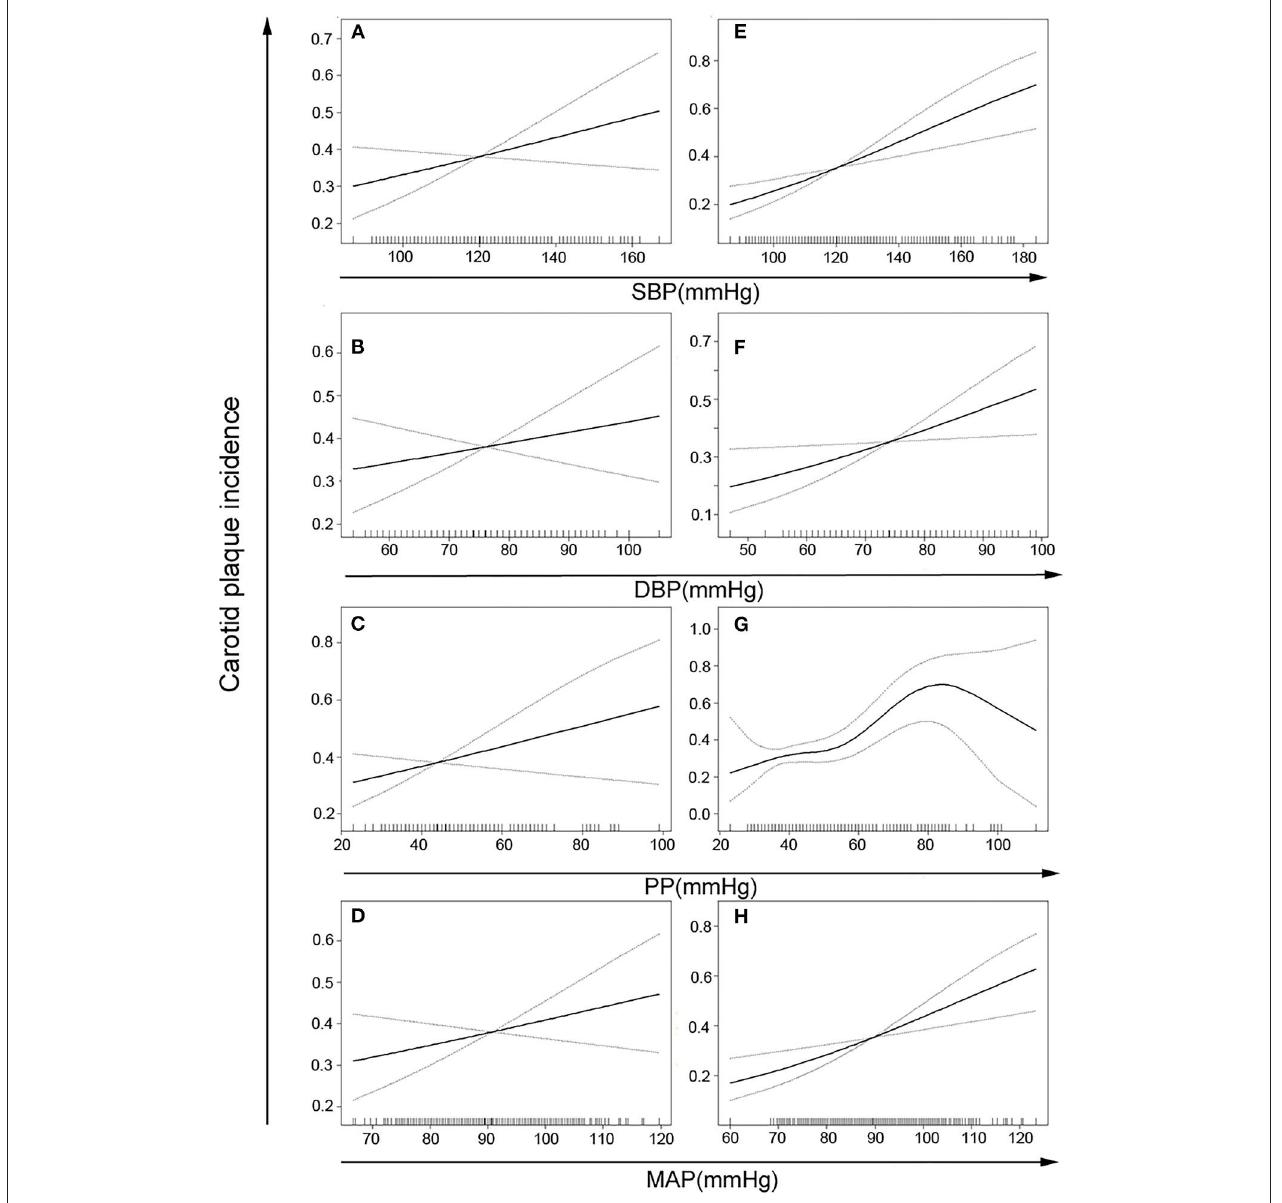
FIGURE 2 | Age-adjusted risks of carotid plaque incidence based on different blood pressure indicators in women (A–D) or men (E–H) . There is a nonlinear correlation in panel G ( p for nonlinear = 0.002) and positive linear correlation in other panels ( p for trend <0.05). SBP, systolic blood pressure; DBP, diastolic blood pressure; PP, pulse pressure; MAP, mean arterial